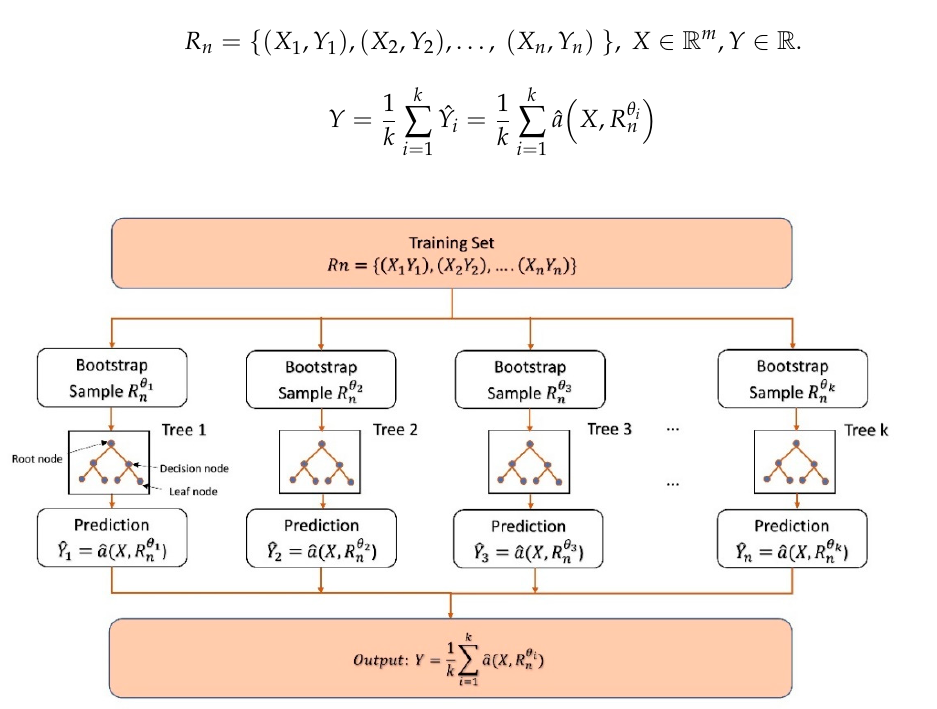
Figure 4. Construction of an RF model.